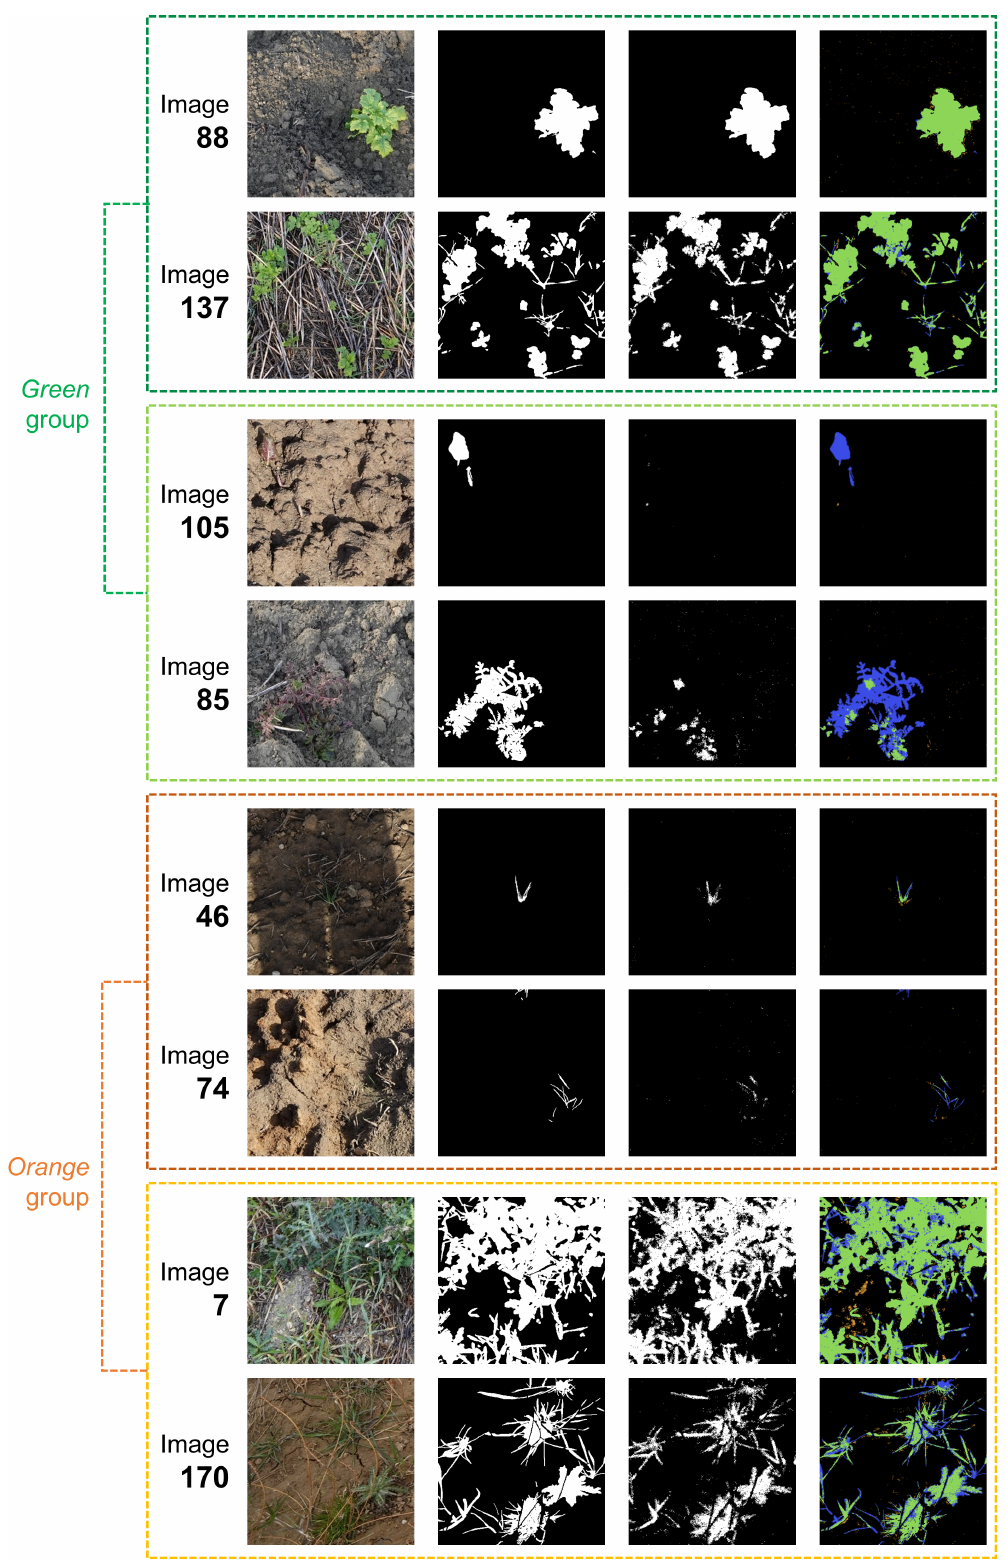
Figure 7. The representative images shown in Figure 6a with their GT, detection, and comparison masks showing the TP, FN, and FP